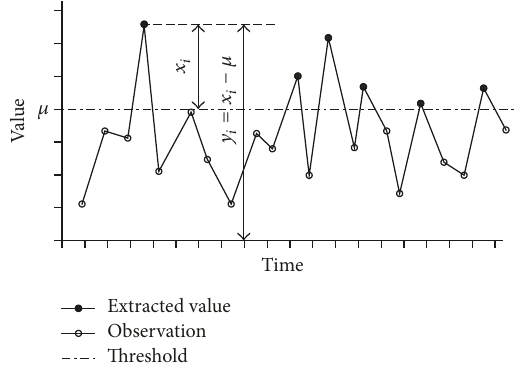
Figure 1: Illustration of the POT